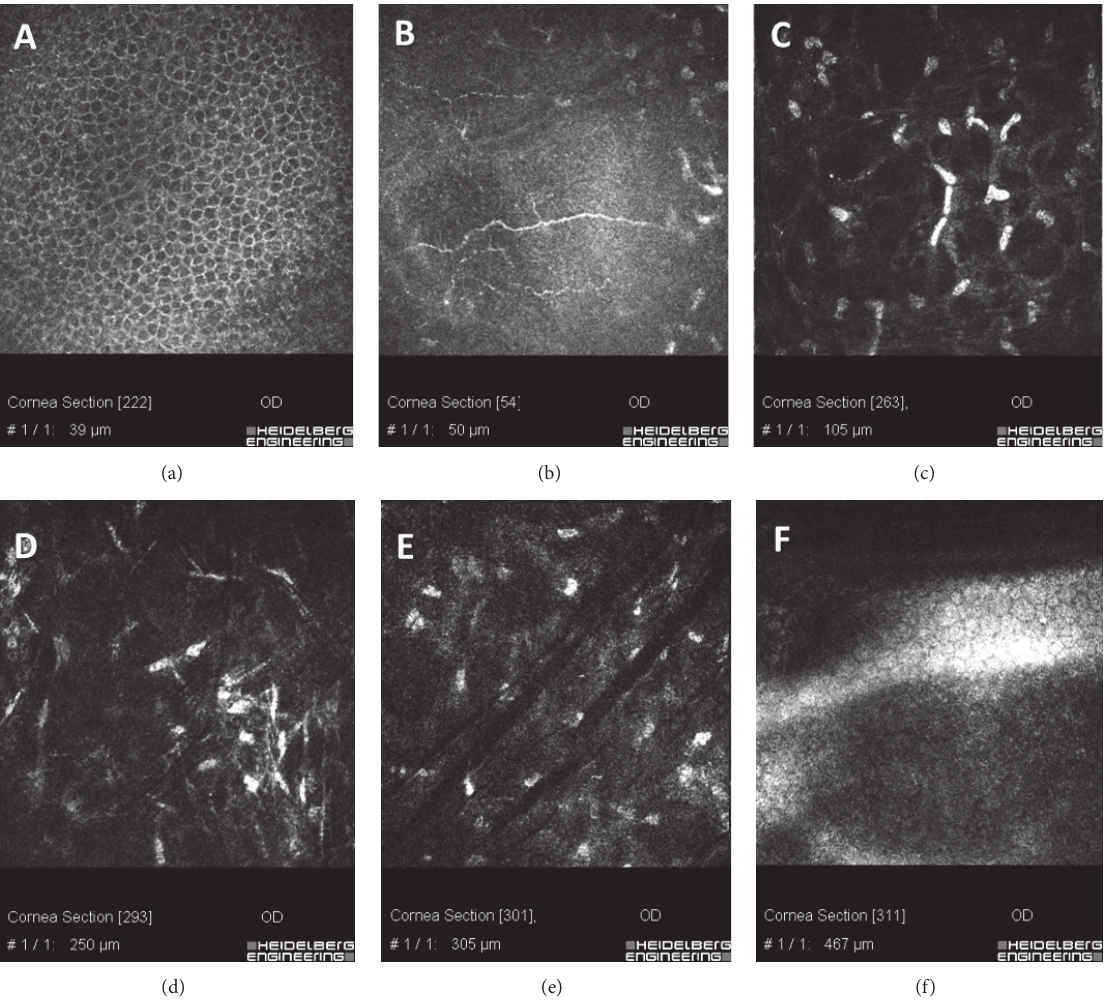
Figure 7: IVCM scans 6 months after high-irradiance topography-guided CXL. Regular epithelium (a) and regenerated subepithelial plexus nerves (b) were evident at 6 months. The hyperreflectivity of extracellular matrix and the lacunar edema gradually disappeared with progressive keratocytes repopulation ((c), (d), and (e)). Oblique dark microstriations are visible (scans 7(d) and 6(e)) in absence of endothelial micromorphological alterations